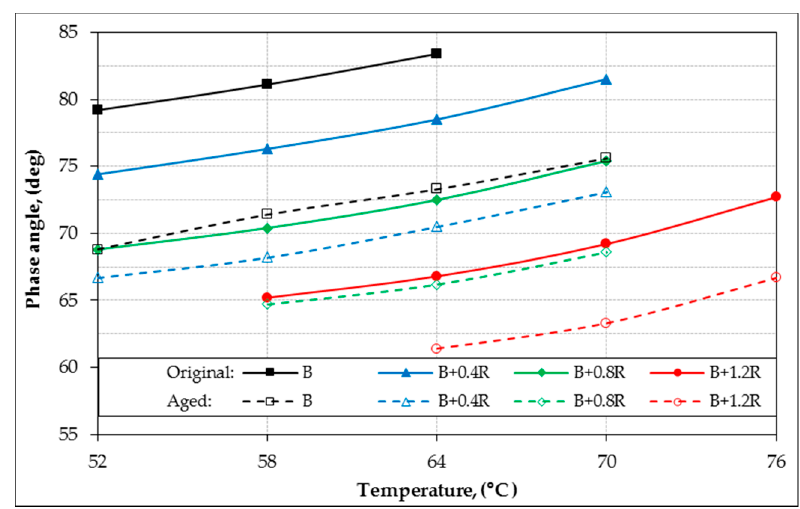
Figure 12. The phase angle ( δ ) and temperature relationship of binders.